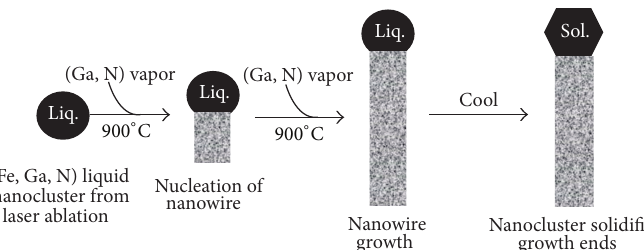
Figure 2: Overall evolution of nanowire growth following the generation of the catalytic nanocluster. Reprinted with permission from [8]. Copyright 2000 American Chemical